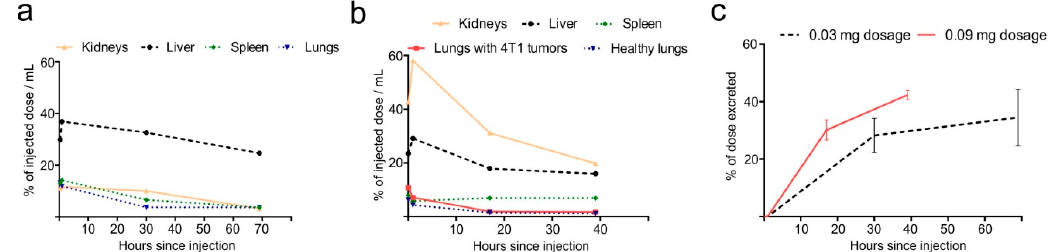
Figure 4. Quantitative analysis of positron emission tomography–computed tomography (PET/CT) images. ( a ) Mean % injected dose (ID)/mL for liver, spleen, kidneys and lungs calculated after imaging at different time-points (20 min, 1 h, 30 h and 69 h) after administration of 0.03 mg dose of Hb-DFO- 89 Zr. ( b ) Mean % ID/mL for liver, spleen, kidneys, lungs with 4T1 tumors and healthy lungs calculated after imaging at different time-points (5 min, 1 h, 17 h and 39 h) after administration of 0.09 mg dose of Hb-DFO- 89 Zr; measurements of radioactivity were decay-corrected. ( c ) Percentage of eliminated radiotracer at different time points following injection: 20 min, 1 h, 30 h, 69 h for 0.03 mg dose and 5 min, 1 h, 17 h, 39 h for 0.09 mg dose. Int. J. Mol. Sci. 2020 , 21 , x FOR PEER REVIEW